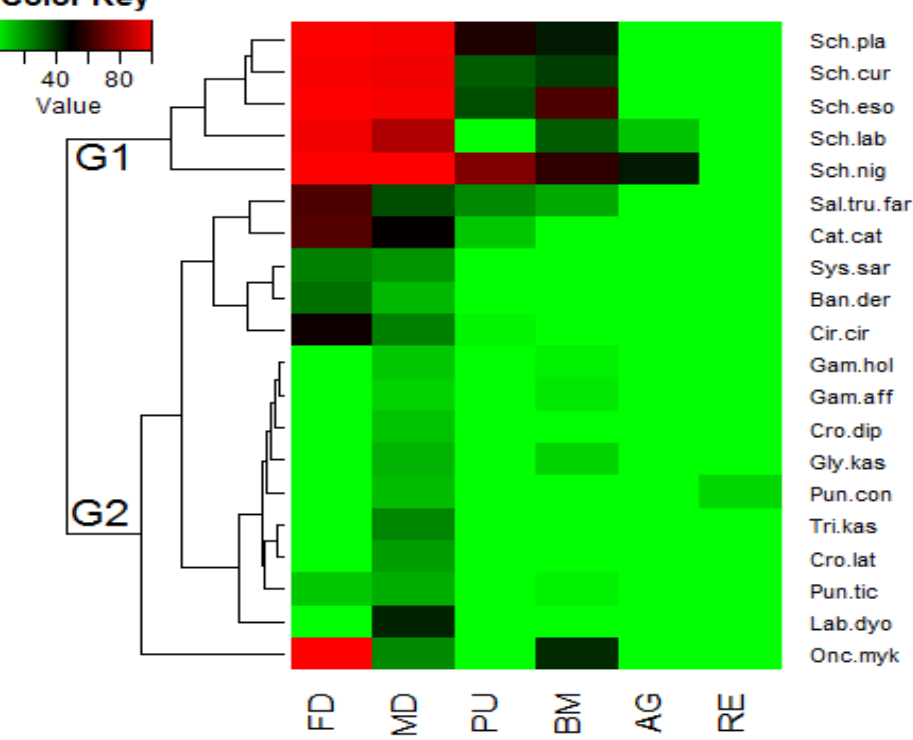
Figure 6. Heat map of cultural usage of documented fishes. Cultural services are categorized into five groups, i.e., food (FD), medicinal (MD), black magic (BM), poultry (PU), agriculture (AG), and recreation (RE). The full names of the species are provided in Table2.